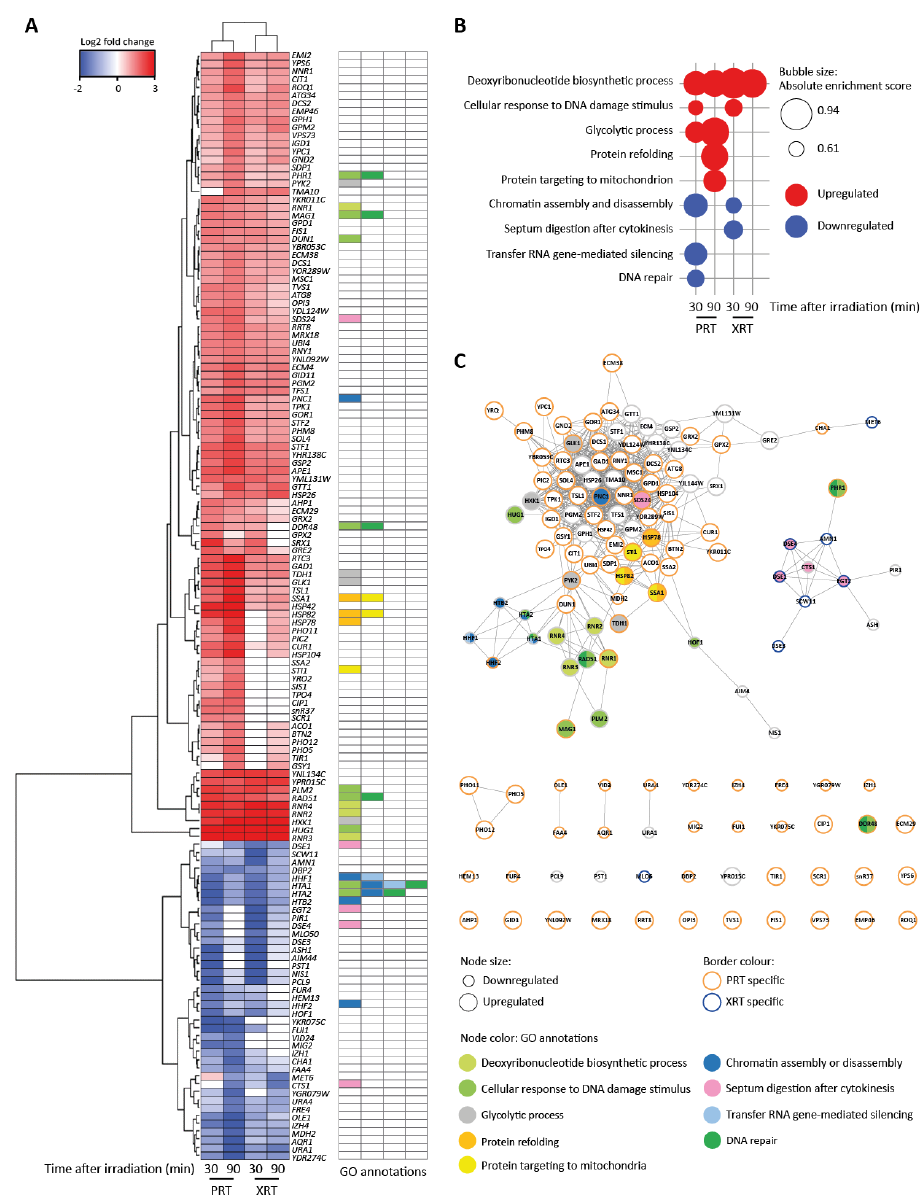
Figure 2. RNA-Seq reveals distinct transcriptional profiles after proton (PRT) and photon radiother- apy (XRT). ( A ) Heatmap for differentially regulated genes. Genes were selected based on two cut-offs: false discovery rate (FDR) < 0.01 and |log2FC| > 1.5 (log2 fold change) in at least one condition. Hierarchical clustering was performed by the Ward.D2 method based on the Euclidian distance. Gene ontology (GO) annotations for enriched GO terms found by gene set enrichment analysis (GSEA) in ( B ) are visualized. ( B ) Enriched GO terms identified using GSEA. GSEA was applied on a ranked gene list based on the log2FC calculated in edgeR. Genes were chosen per condition based on two cut-offs: FDR < 0.01 and log2FC < − 1.5 for downregulated genes or log2FC > 1.5 for upregulated genes. For GSEA, the FDR was set at 0.25. ( C ) Interaction network of genes in ( A ). The network was built in String [43] and visualized in Cytoscape [44]. The node size corresponds to either up- or downregulated genes. Nodes with orange borders are genes only found to be deregulated after PRT. Nodes with blue borders are genes only found to be deregulated after XRT. Nodes with grey borders are genes deregulated after both PRT and XRT. Node colors represent the GO categories found in ( B